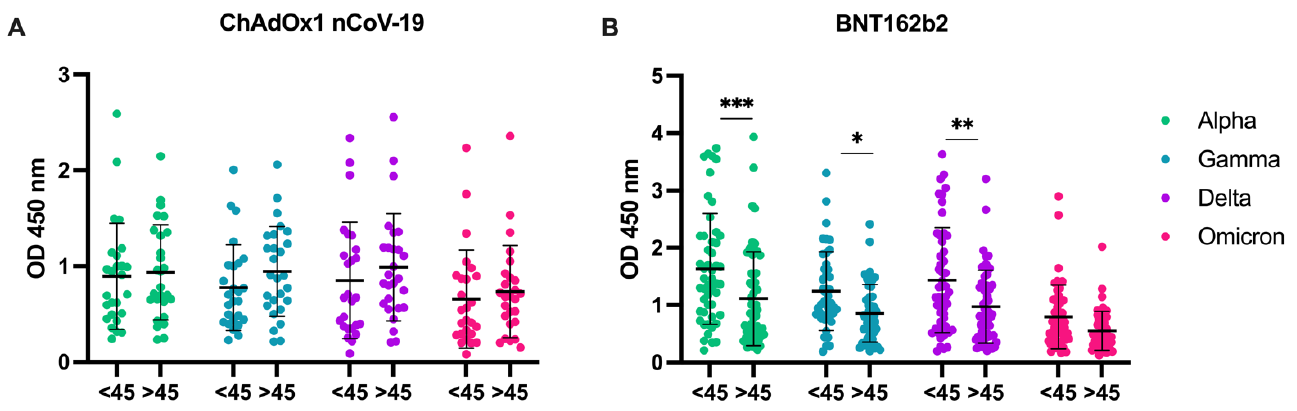
( A ) Participants who received the first dose of ChAdOx1 nCoV-19. ( B ) Participants who received the